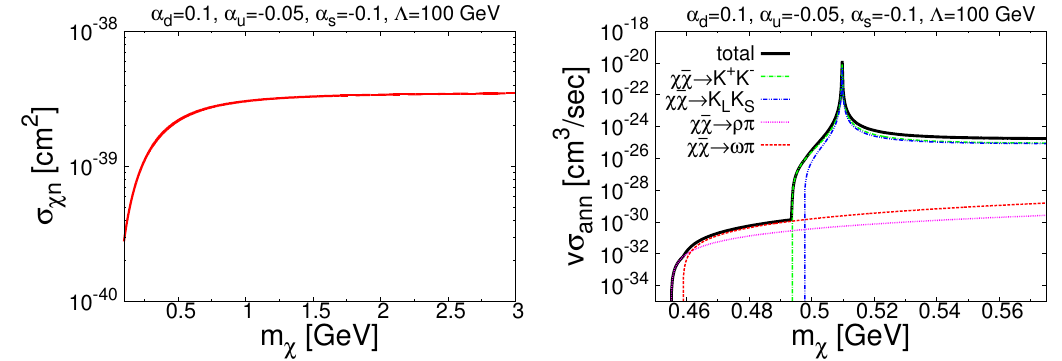
Figure 10 . Left-panel: The DM-neutron scattering cross section in the relativistic limit for DM capture by a NS with M = 1 : 44 M (cid:12) and R = 10 : 6 km. Right-panel: The (cid:31) (cid:22) (cid:31) annihilation cross p sections for s (cid:20) 1 : 15 GeV including interference